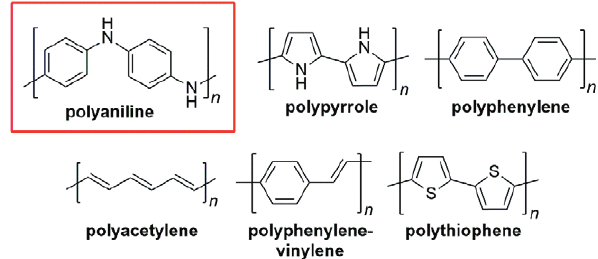
Figure 1. Common parent conjugated organic polymers.